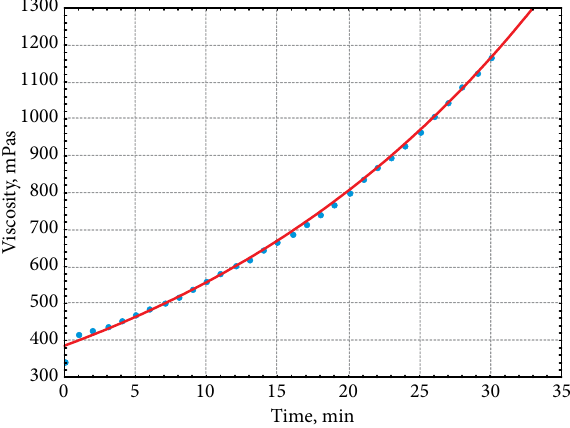
Fig. 7. The relationship of viscosity and time in cement paste containing 10 wt% of synthetic